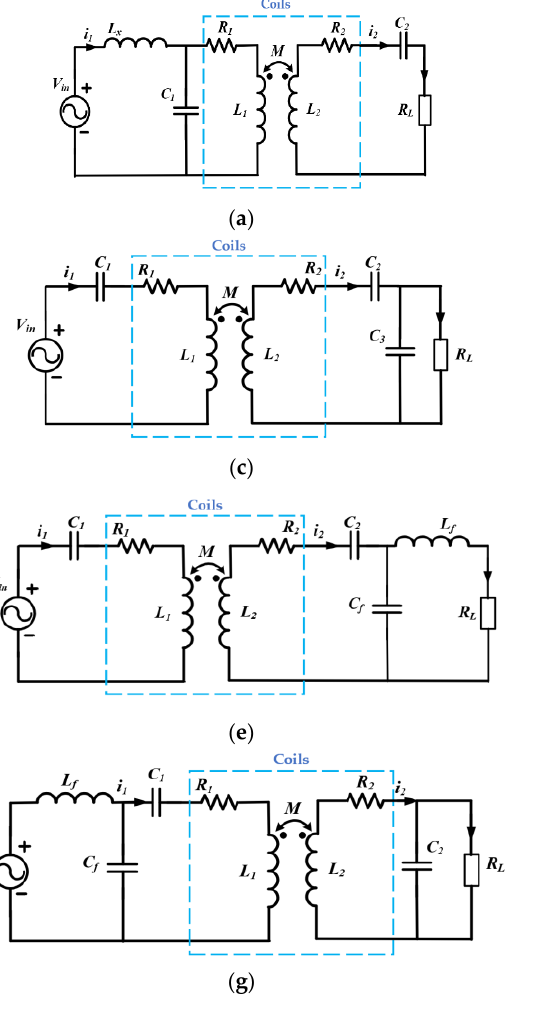
Figure 9. Multi-element resonant compensations. ( a ) PS with L x . ( b ) PP with L x . ( c ) Series/series– parallel (S/SP). ( d ) LC-LC (LCL-LCL). ( e ) S-LCC. ( f ) LCC-S. ( g ) LCC-P. ( h ) LCC-LCC.